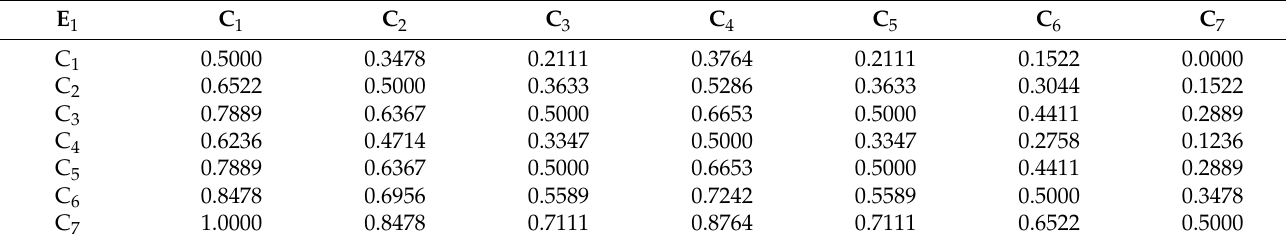
Table 8. Linear solution for transformation matrix of criteria in Taiwan.